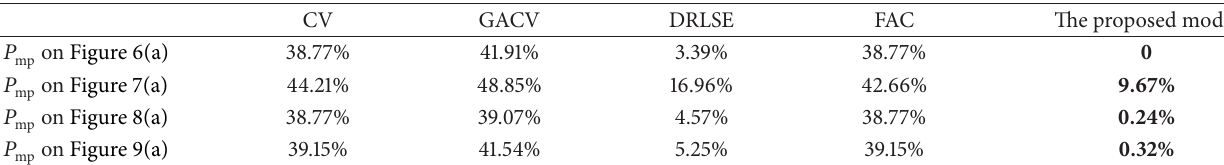
Table 1: Quantitative result given by different